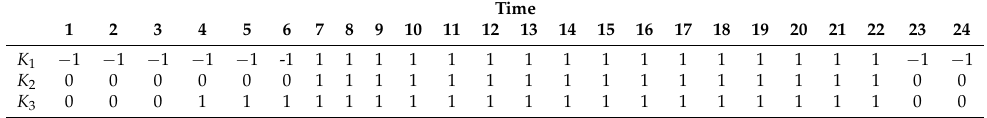
Table 7. The values of the transmission factors K 1 , K 2 , and K 3